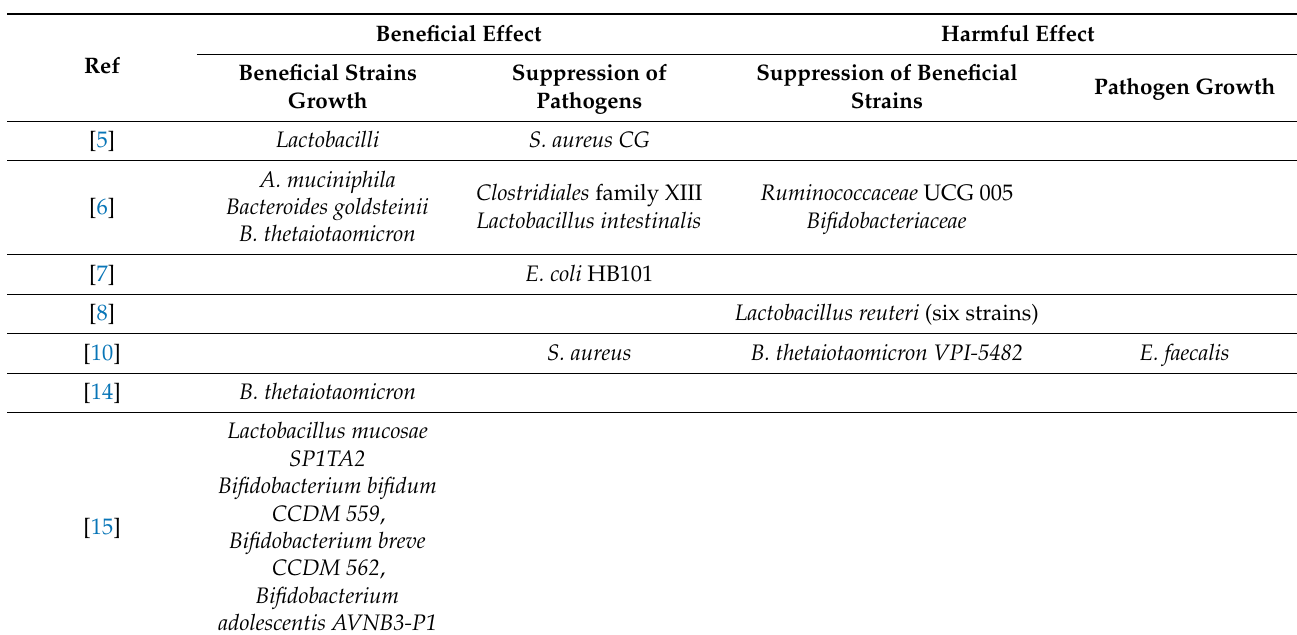
Table 4. The effects of stevia glycosides on certain beneficial and harmful bacteria growth in in vitro and in vivo studies, without any dietary